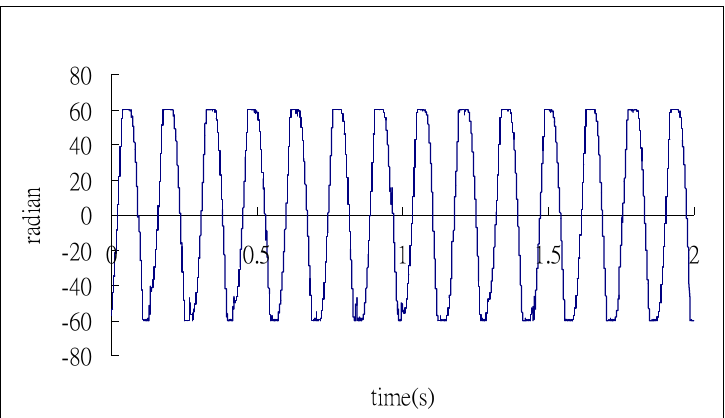
Figure 8. Demodulated phase shift with excitation frequency of 7 Hz.